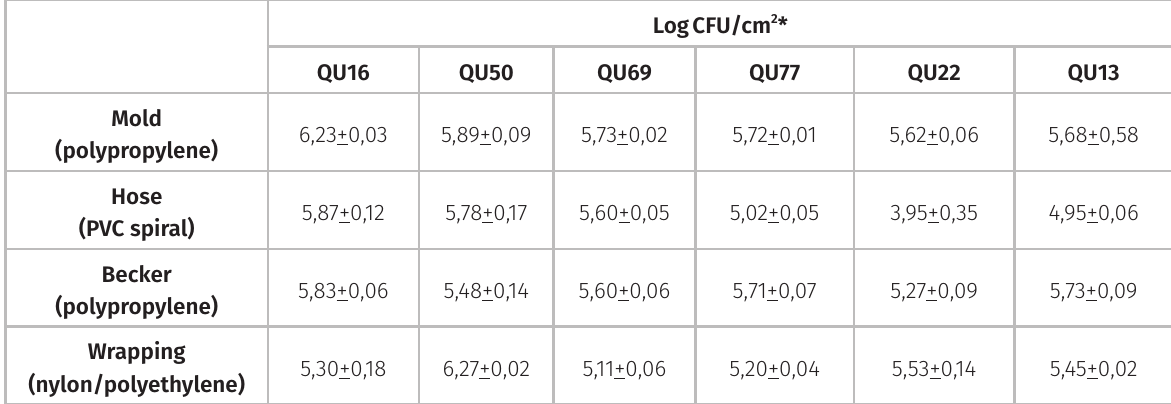
Table I. Counting of sessile cells of Yarrowia lipolytica isolates adhered to coupons during the biofilm formation